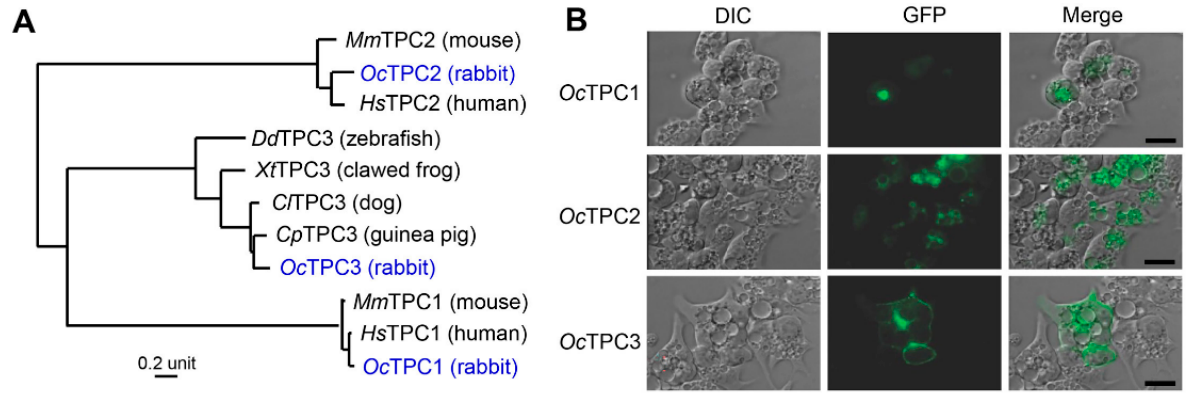
Figure 1. Rabbit TPC1, TPC2, and TPC3 are distantly related and exhibit differential subcellular locations when expressed in HEK293 cells. ( A ) Phylogenetic tree of three vertebrate TPC subtypes, with the rabbit sequences highlighted in blue. Multiple sequence alignment was made using ClustalW (https://www.genome.jp/tools-bin/clustalw (accessed on 11 May 2022)) and the tree generated using the PhyML algorithm. GenBank accession numbers are: TPC1, ON502176 (rabbit), NP_060371.2 (human), NP_665852.1 (mouse); TPC2, ON502177 (rabbit), NP_620714 (human), NP_666318 (mouse); TPC3, EU344155.1 (rabbit); NP_001184074 (dog); XP_013002737 (guinea pig); XM_002940341 (Western clawed frog), NP_001170916 (zebrafish). ( B ) DIC and epifluorescence im- ages of HEK293 cells transiently transfected with cDNA coding for Oc TPC1-EGFP, Oc TPC2-EGFP,